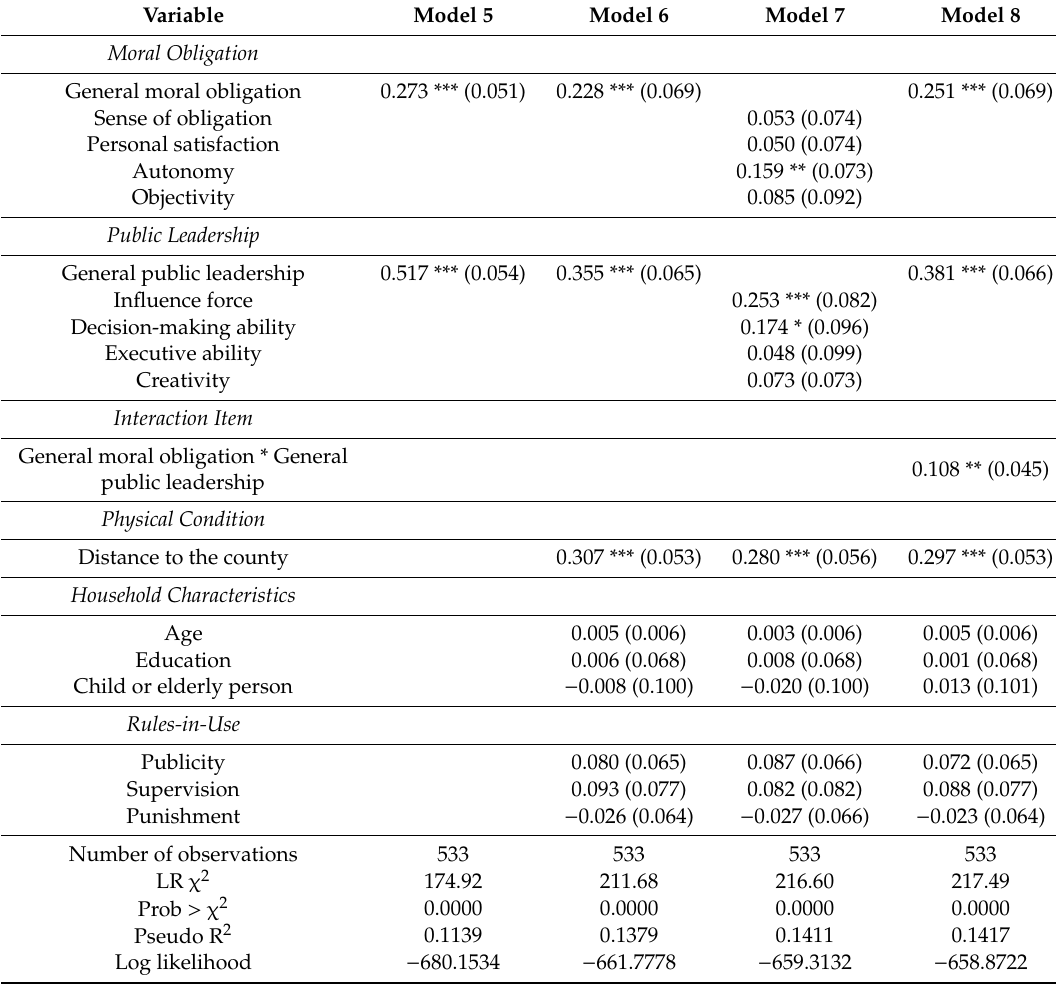
Table 5. The e ff ects of moral obligation and public leadership on villagers’ frequency of wearing a mask when going